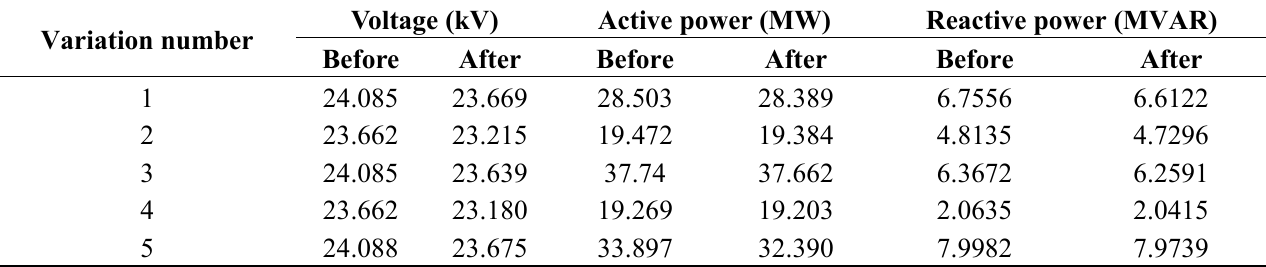
Table 4. Korean EMS data for the 1509th transformer bank on summer